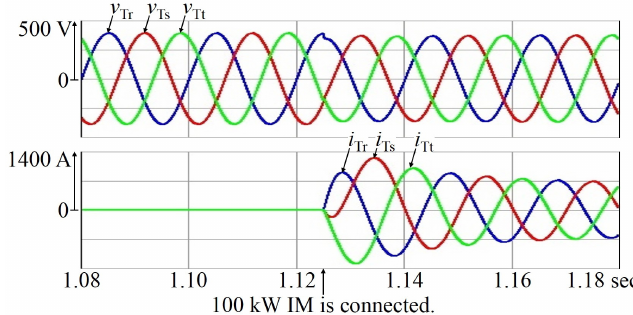
Figure 7. Magnified waveforms for Figure 6.